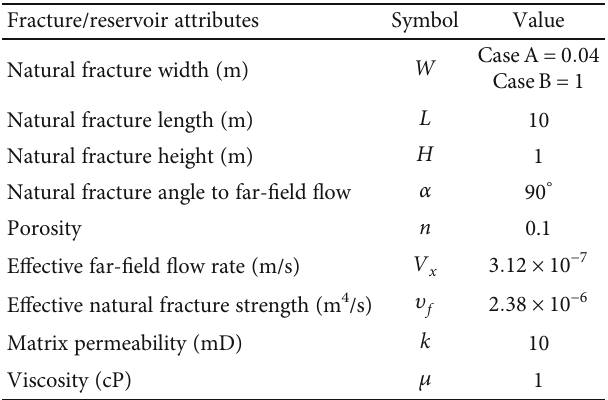
Figure 7: Pressure contours (in Pa) for fracture properties listed in Table 4. Case A (a): fracture width is 0.04m. Case B (b): fracture width increased to 1m. The far- fi eld fl ow with a net e ff ective velocity of 3 : 12 × 10 − 7 m/s fl ows from bottom to top. The e ff ective strength of the natural fracture is 2 : 38 × 10 − 6 m 4 /s . The natural fracture is oriented at angles of (A and B) 0 ° , (C and D) 45 ° , and (E and F) 90 ° , with respect to far- fi eld fl ow direction. Table 4: Fracture and reservoir attributes for fractures oriented at di ff erent